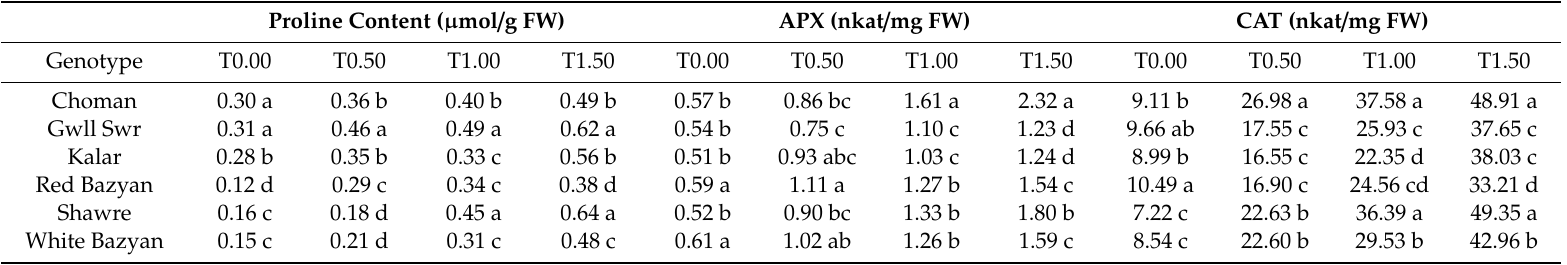
Table 7. Influence of drought stress on the proline content, ascorbate peroxidase (APX), and catalase (CAT) activities in the callus of six rice genotypes. The results displayed are the average of three replicates. Di ff erent letters within a column suggest a significant variation between mean values by Duncan’s multiple-range analysis ( p ≤